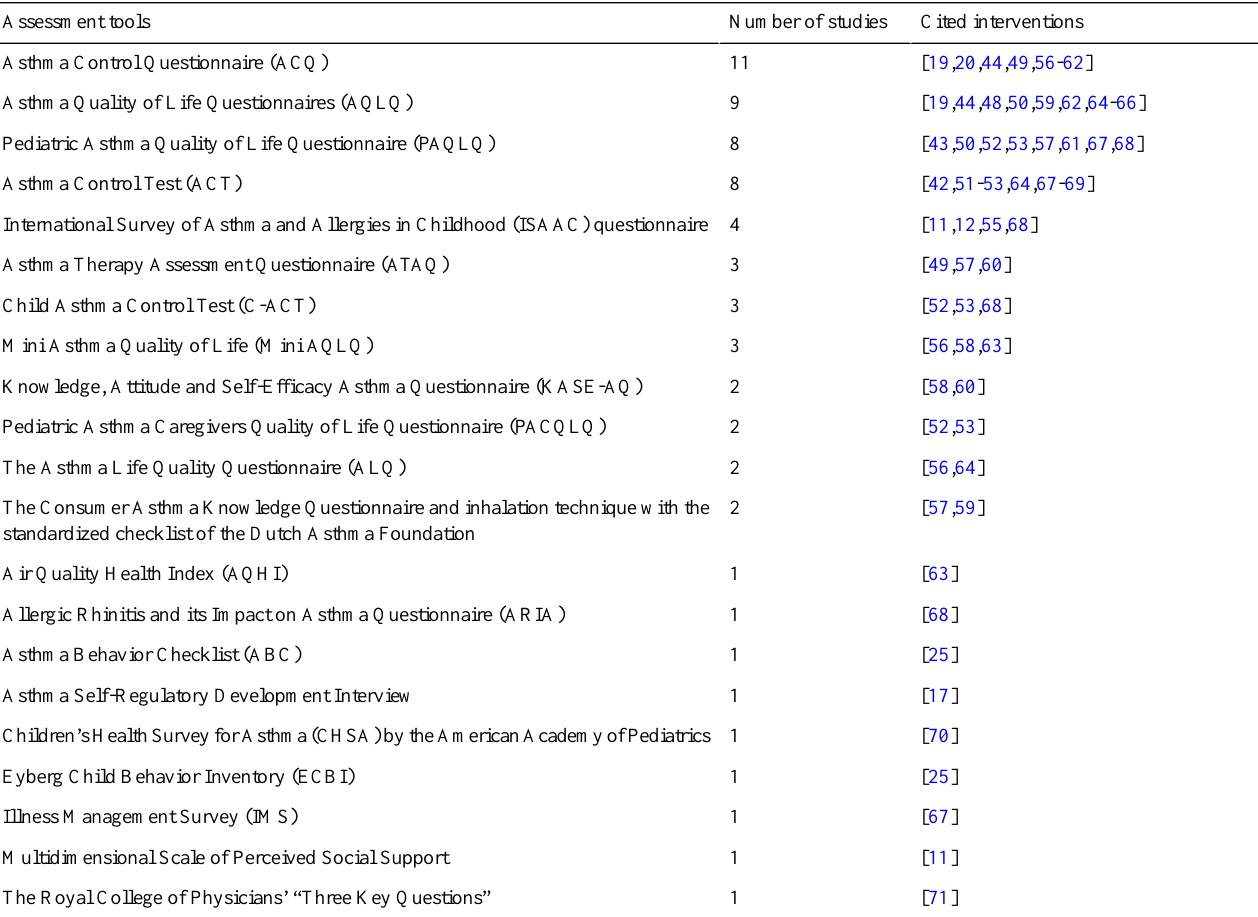
Table 4. Applied assessment tools of the 85 reviewed Internet-based asthma interventions.